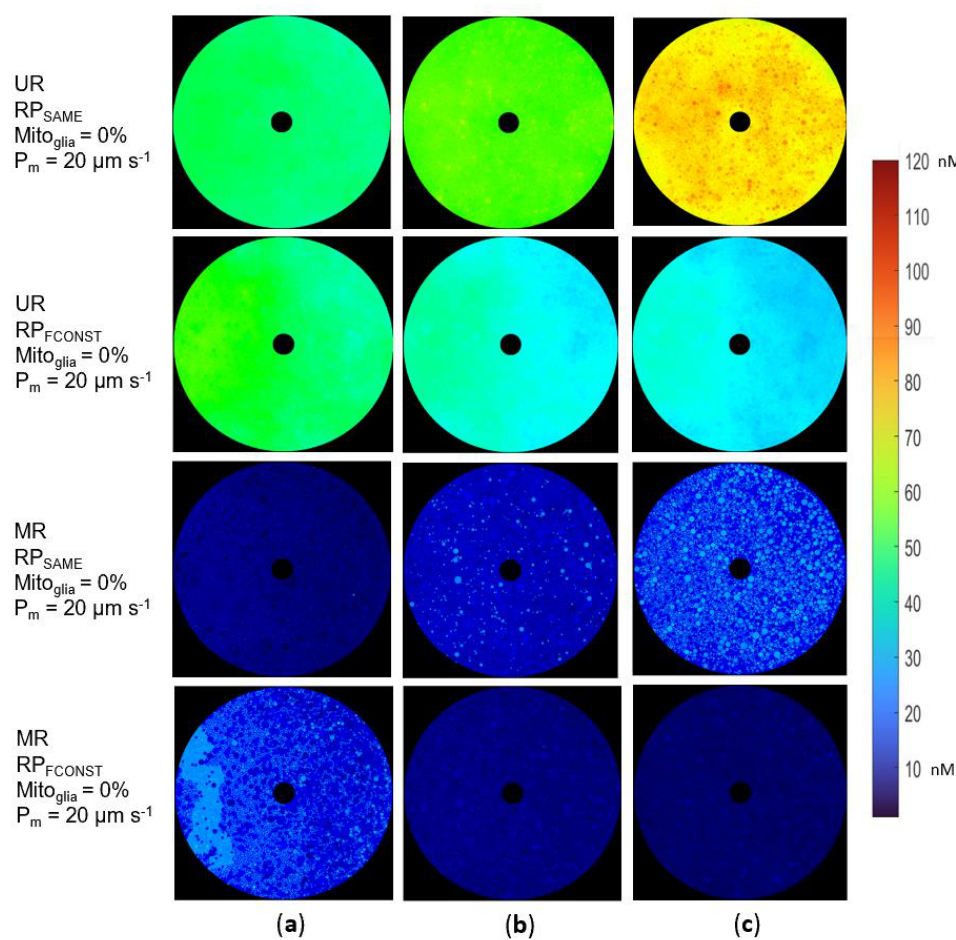
Figure 6 . Coronal plane views of simulations show [H 2 O 2 ] gradients from the RP SAME and RP FCONST ROS production models in both myelinated (MR) and unmyelinated regions (UR): ( a ) [H 2 O 2 ] varia- tions at an axonal mitochondria volume ratio (mito%) of 4%; ( b ) [H 2 O 2 ] values and gradients when the mito% doubles (8%); ( c ) [H 2 O 2 ] values and gradients when the mito% is 12%. [H 2 O 2 ] was highest in simulations of unmyelinated regions which used the RP SAME production hypothesis, with many localized values close to the oxidative stress threshold.